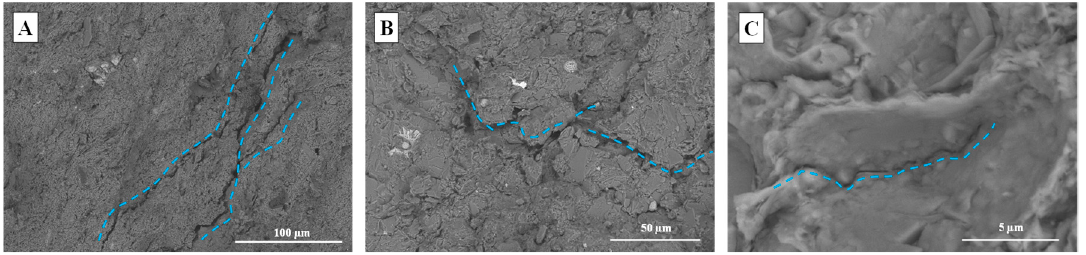
Figure 7. Newly formed fractures after the experiment on different scales, ( A ) sample #16, ( B , C ) sample #12.